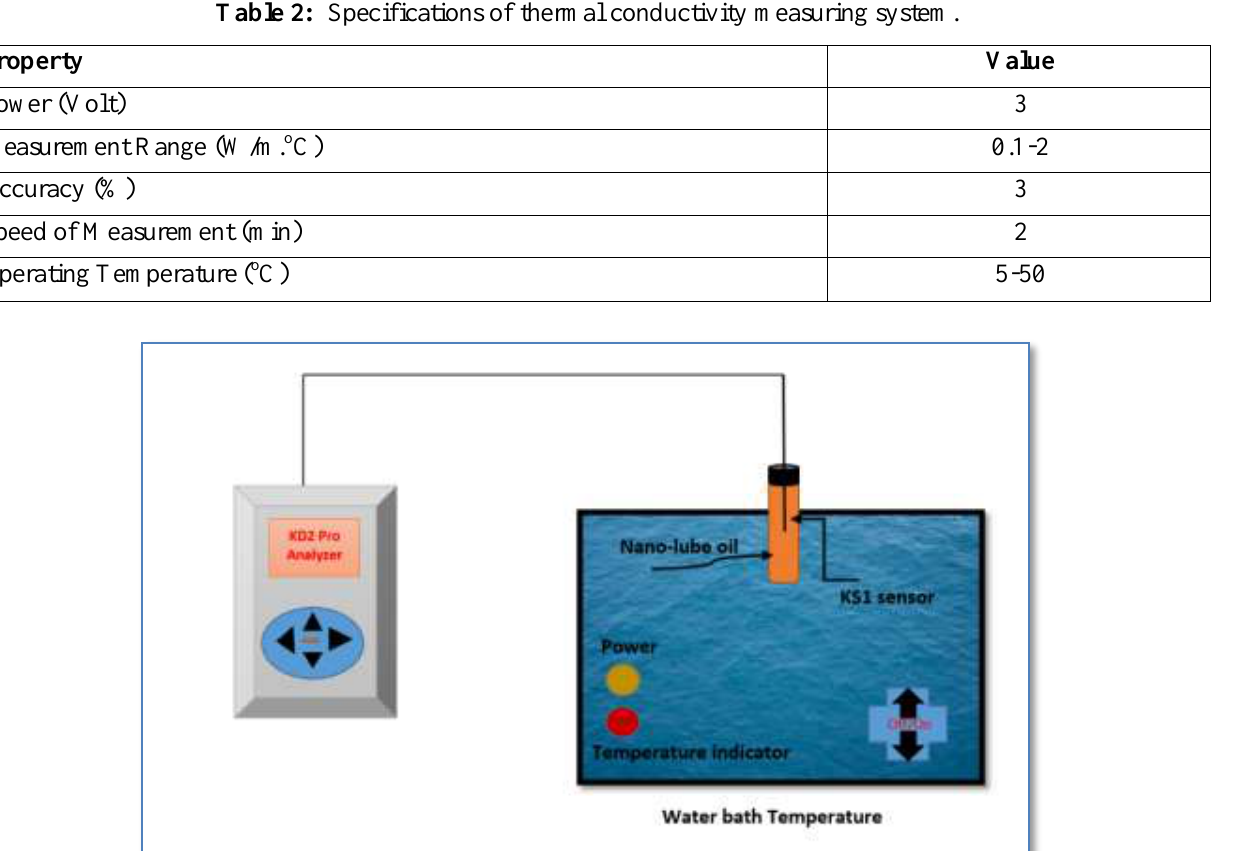
Figure 3: Schematic representation of the thermal conductivity measuring